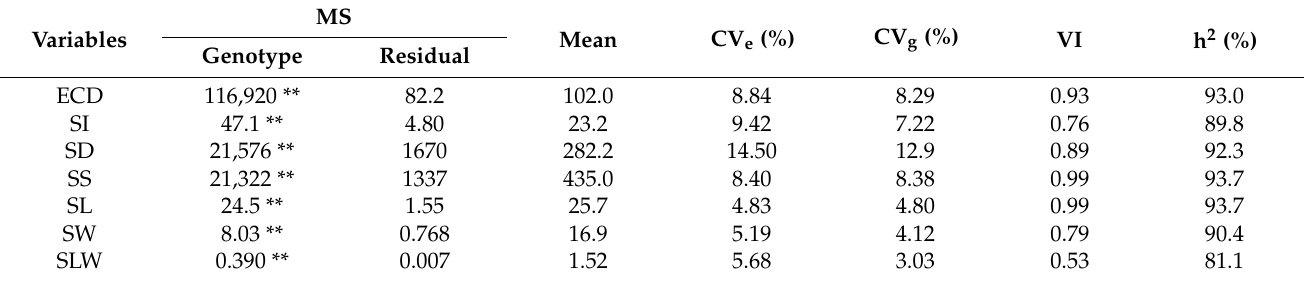
Table 2. Summary of analysis of variance for the leaf morpho-anatomical traits evaluated in 43 genotypes of Coffea canephora . MS Variables